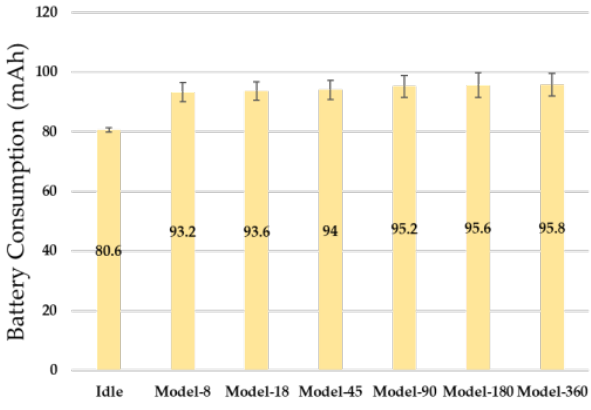
Figure 13. Battery Consumption of six Neural Network Models.